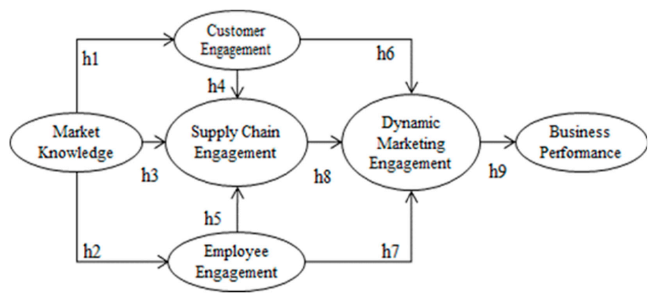
Figure 1. The empirical research model.